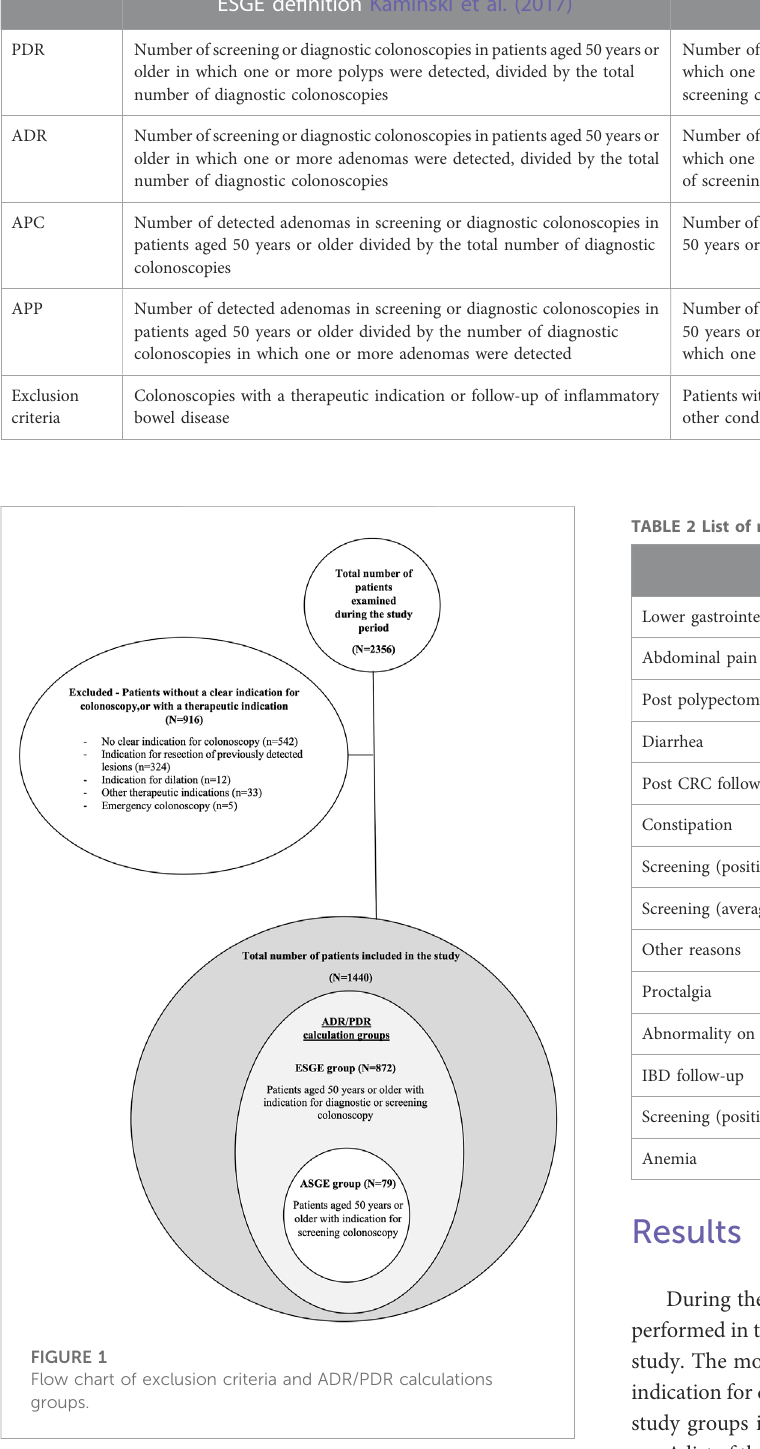
Table 2. The percentage of screening colonoscopies (all ages) was 14.38%, 6.32% of which were patients with a family history of CRC or advanced adenoma, and 1.46% were patients with previously positive FOBT.